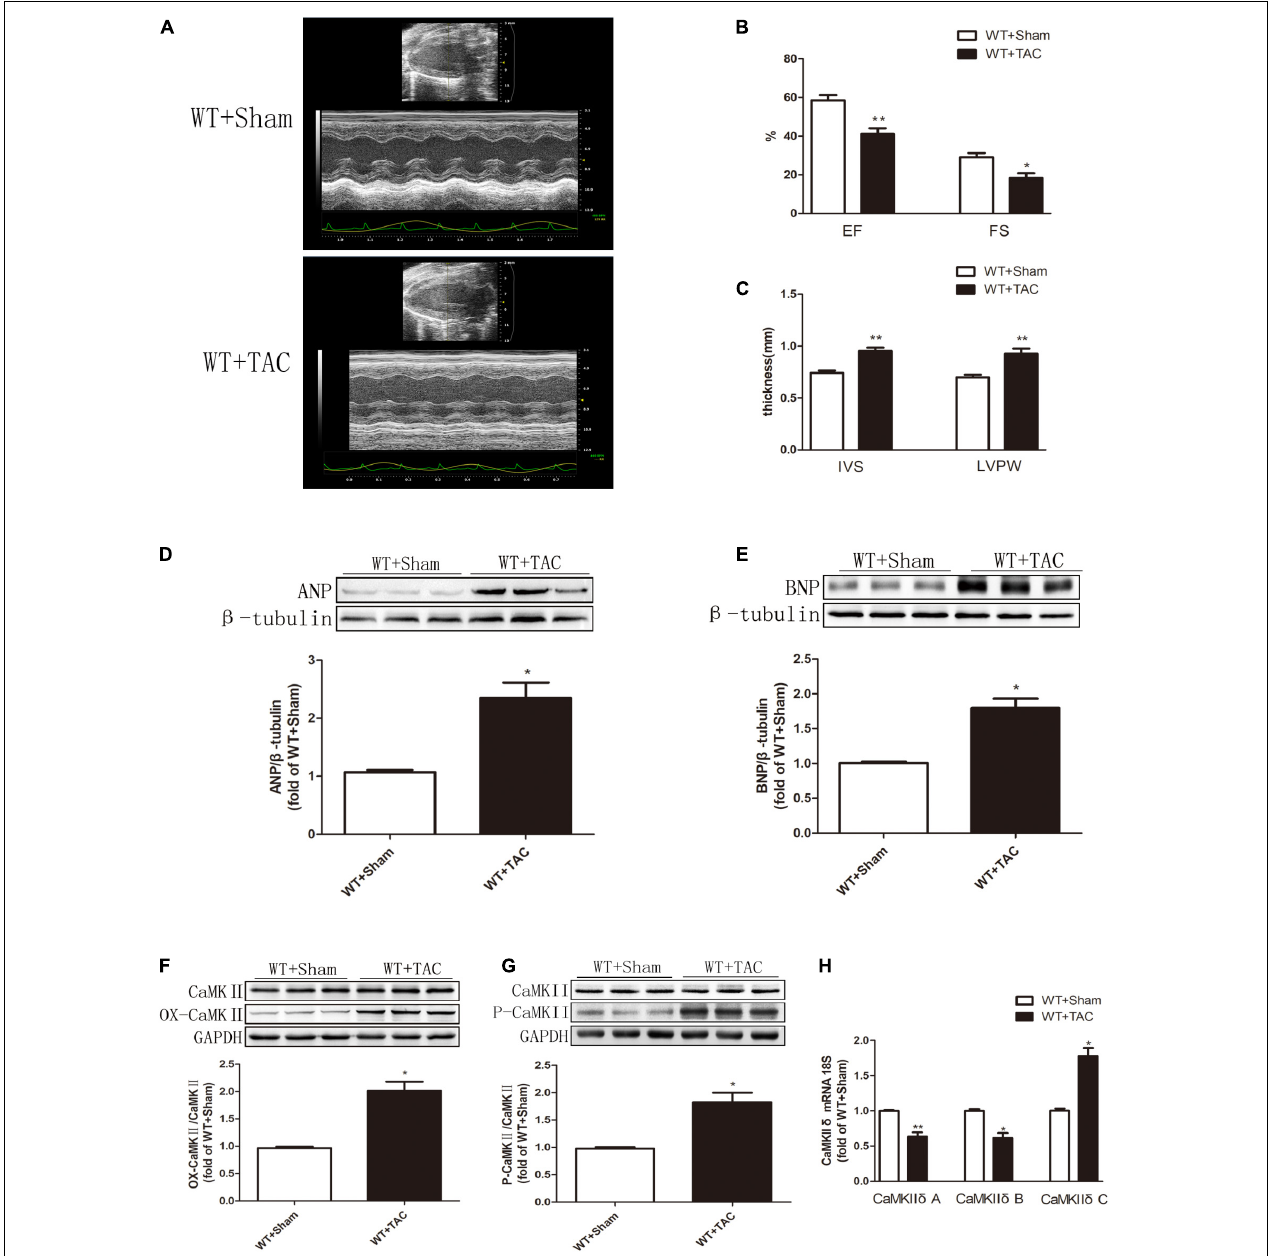
FIGURE 1 | Cardiac dysfunction, increased expressions of ANP and BNP, CaMKII δ alternative splicing disorder, CaMKII oxidation, and phosphorylation levels are increased in HF mice. Male 8-week-old C57BL/6 mice were treated with TAC using a 28-g needle. The control group received sham surgery. All groups of mice were given continuous feeding for 6 weeks. Hearts were then obtained for correlative testing. (A) Echocardiography. (B) EF and FS. (C) IVS and LVPW. (D) The expression of ANP at the protein level in myocardial tissue was detected by Western blotting analysis, and β -tubulin was used as a loading control; (E) The expression of BNP at the protein level in myocardial tissue was detected by Western blotting analysis, and β -tubulin was used as a loading control. (F) Western blotting analysis was used to detect the expression of OX-CaMKII protein in myocardial tissue, and GAPDH was used as loading control; (G) Western blotting was used to detect the expression of P-CaMKII protein in myocardial tissue, and GAPDH was used as a loading control. (H) Detection of myocardial CaMKII δ A, CaMKII δ B, and CaMKII δ C at the mRNA level by qRT-PCR, and 18S was used as the housekeeping gene. Compared with the WT + sham group, ** P < 0.01 and * P < 0.05. n = 6.